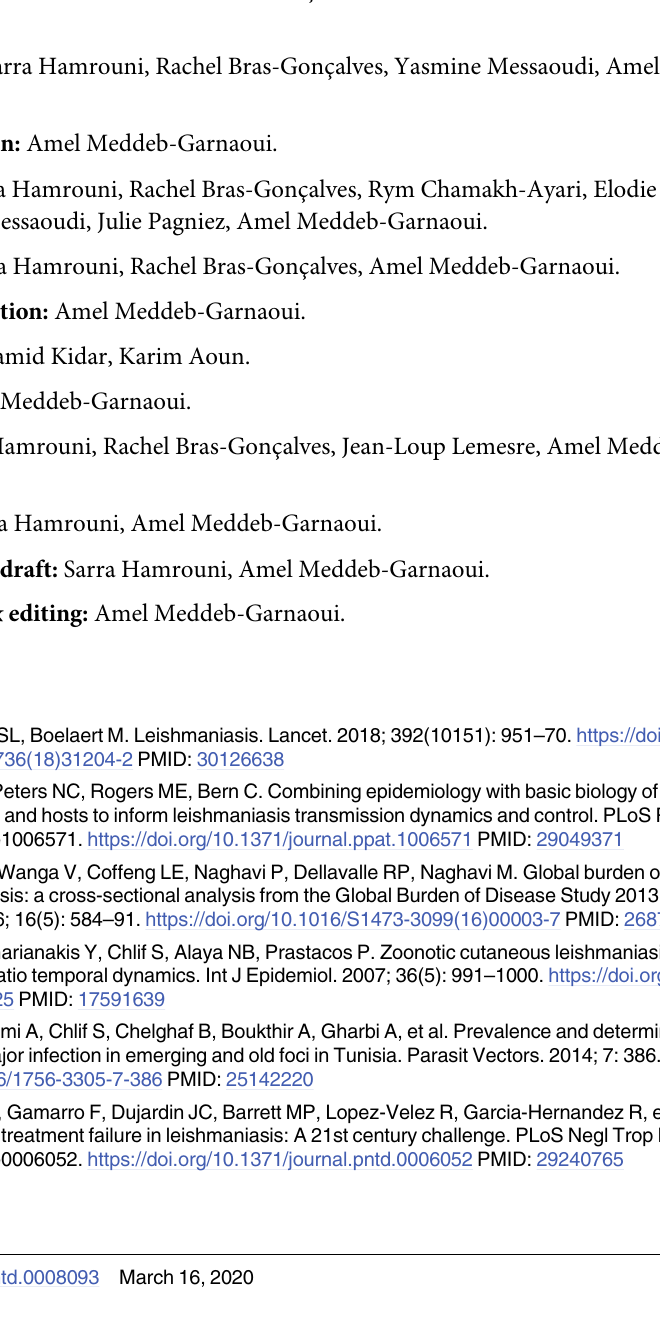
S5 Fig. Gating strategy used to assess CD4+ and CD8+ memory T cell.